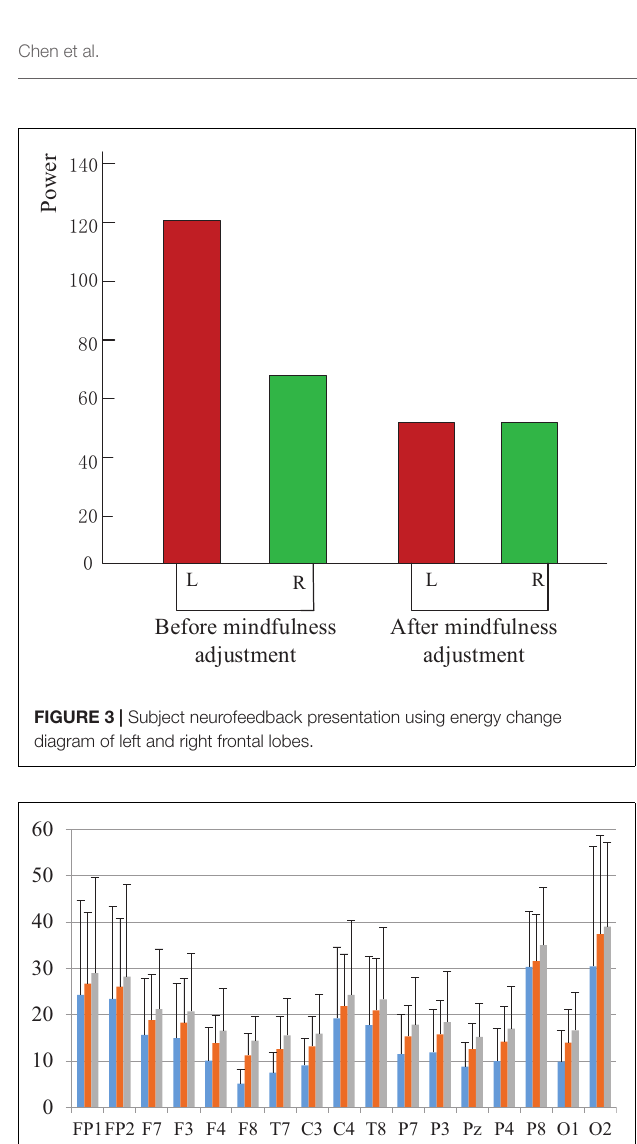
The second stage The third stage FIGURE 4 | The characteristics of alpha wave power changes in whole brain regions of anxious subjects in the three experimental stages.